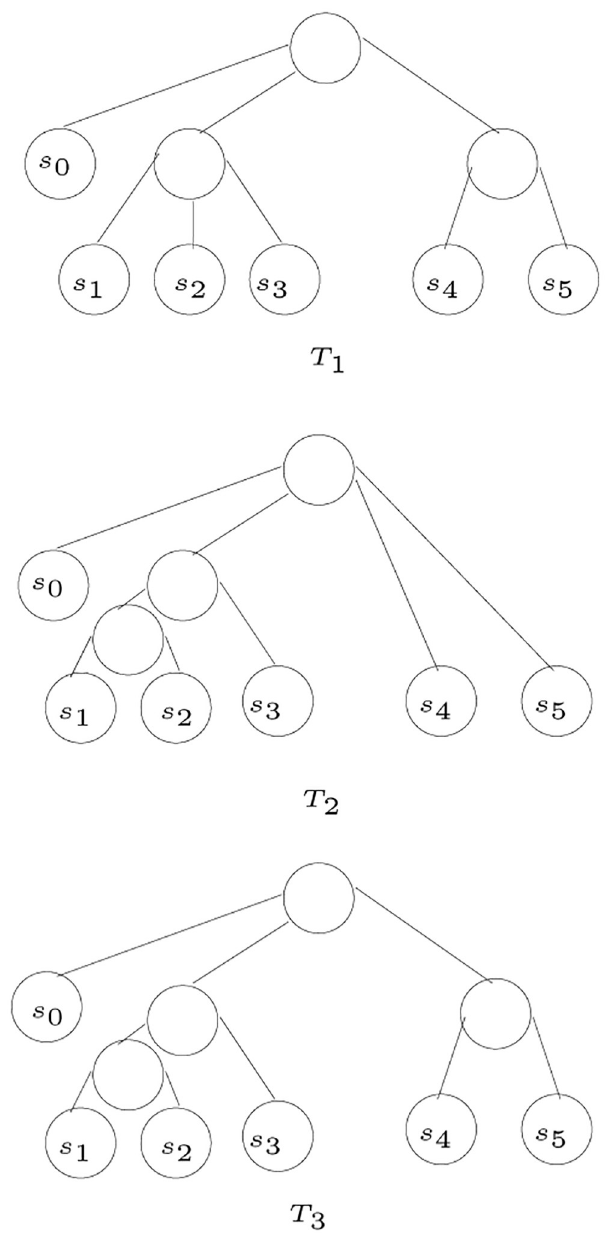
Fig 30. An example to illustrate the algorithm MinCommonRefine.